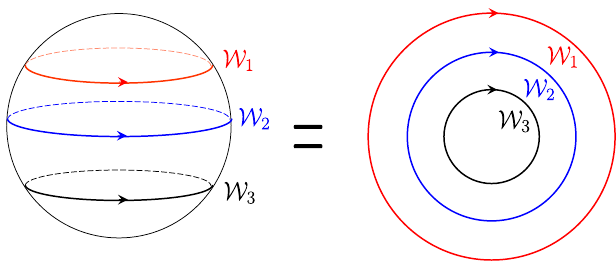
Figure 5 . Multiple 1 = 8-BPS loops with the same orientations. The left (cid:12)gure is a con(cid:12)guration drawn on S 2 while the right (cid:12)gure is the same con(cid:12)guration viewed from the south pole and projected to a plane. We denote the area inside W j (in the right (cid:12)gure) by A j